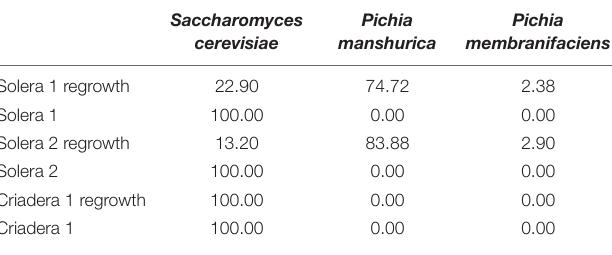
TABLE 1 | Species identified by ITS-metabarcoding, localization, and frequency (%) in each